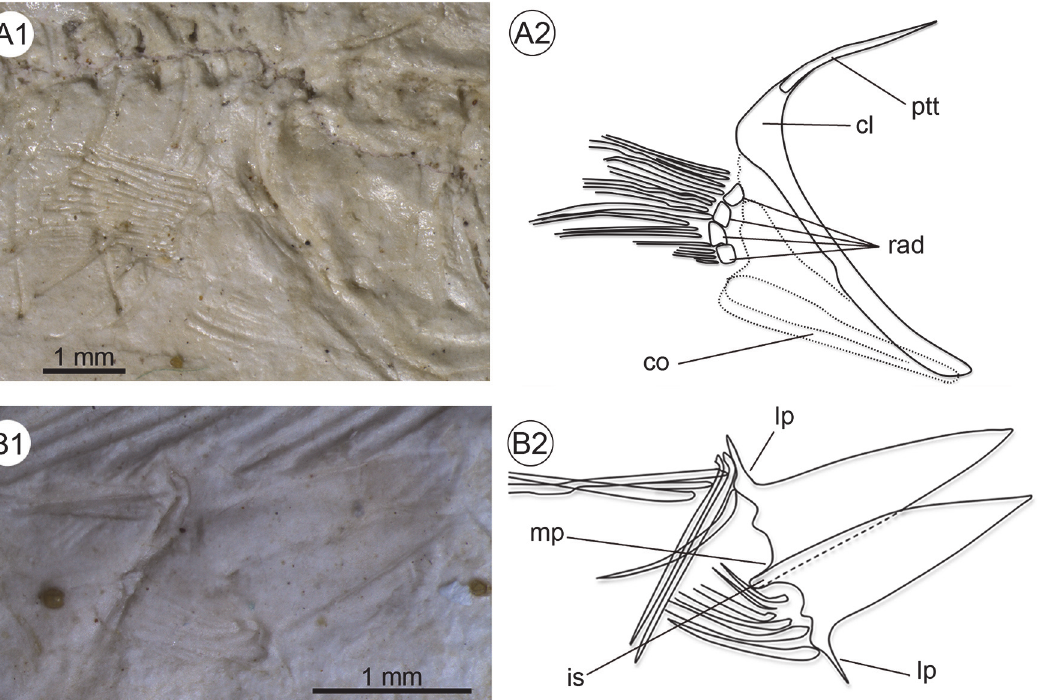
Fig 6. Details of the pectoral and pelvic girdles and fins seen in † Kenyaichthys kipkechi sp. nov., right lateral views. A1 – A2 Pectoral girdle and fin (paratype 1192´04); B1 – B2 Pelvic girdle and fin (paratype 1218a´05). Abbreviations: cl, cleithrum; co, coracoid; is, ischial process; lp, lateral process; mp, medial process; ptt, posttemporal; rad, pectoral